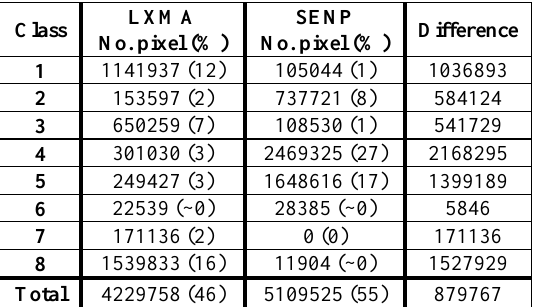
Table 4. Number of pixels considered for each of the classes in each of the study areas. Within brackets percentage of the area occupied by each class of the OSM derived data when considering the whole study area of each region.